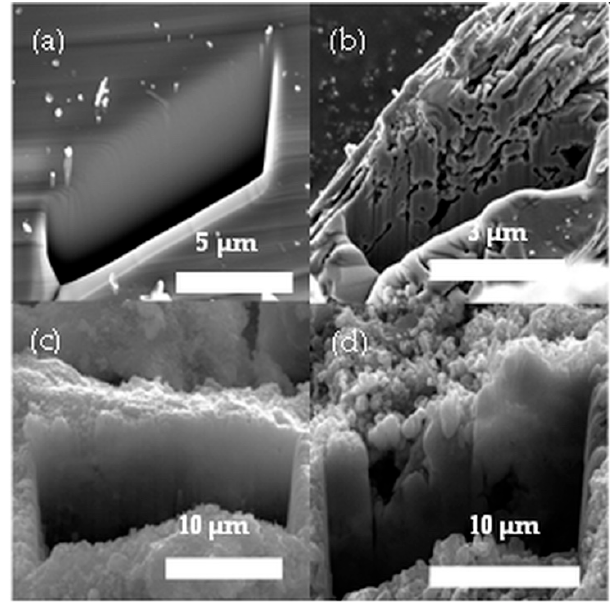
Figure 2. Cross-section images of (a) untreated 6H–SiC, (b) etched 6H–SiC, (c) untreated 3C–SiC, (d) etched 3C–SiC. ( d ) etched